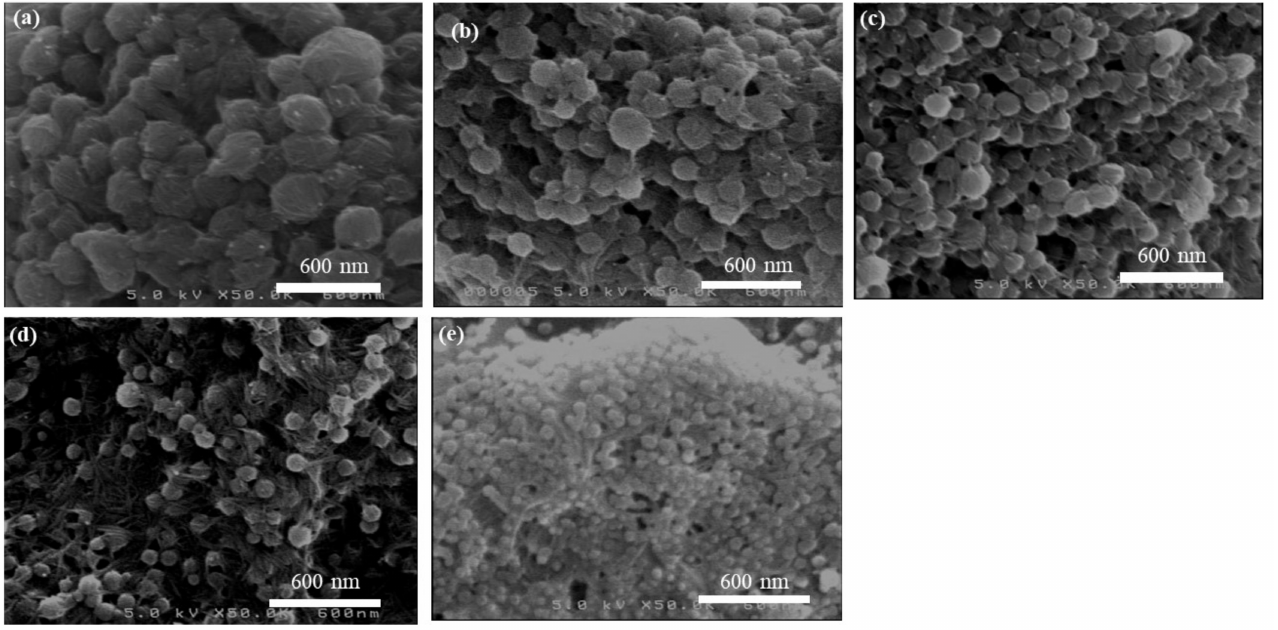
Figure 6. SEM images of SD-ChNF/polystyrene composite particles for ( a – e ) runs